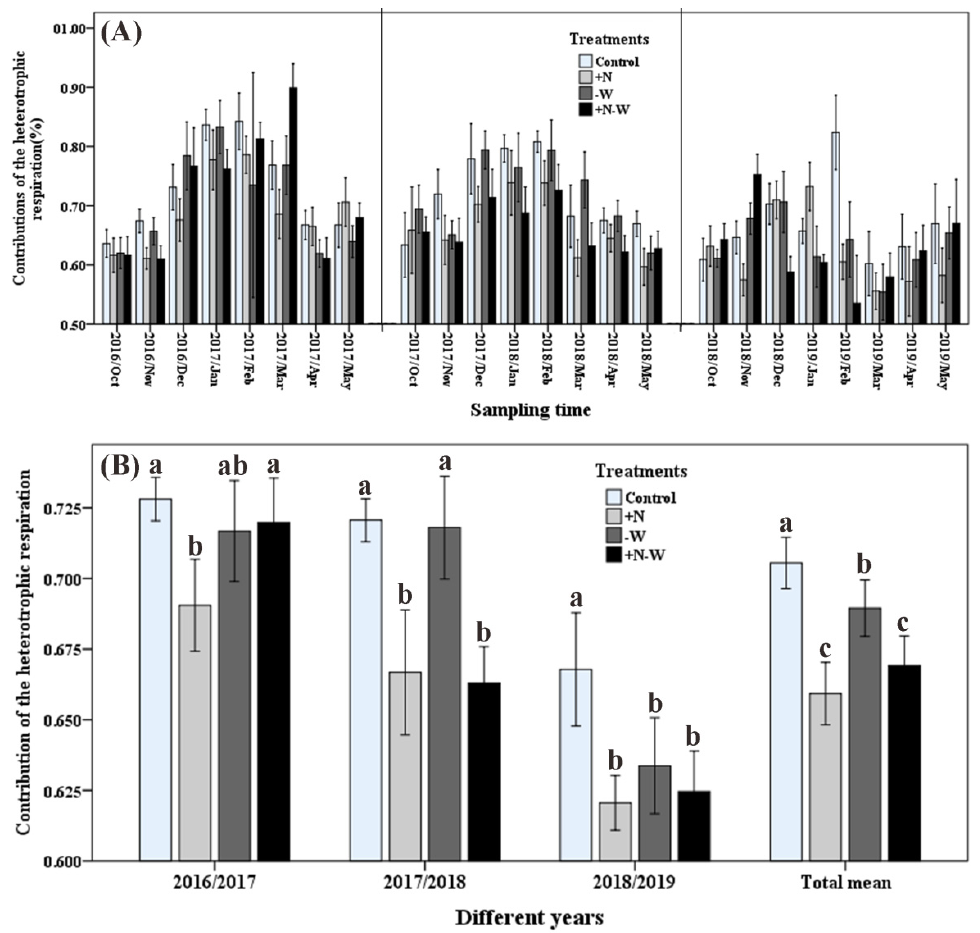
Figure 5. The contribution of heterotrophic respiration to total soil respiration in the each measurement periods ( A ) and each nongrowing season ( B ) in the 2016 / 2017, 2017 / 2018, and 2018 / 2019. Significant di ff erences among the di ff erent treatments are indicated by di ff erent letters. The error bars are standard errors. + N represents the N addition treatments; -W represents the precipitation reduction treatments; and + N-W represents the combined e ff ect of N addition and precipitation reduction.